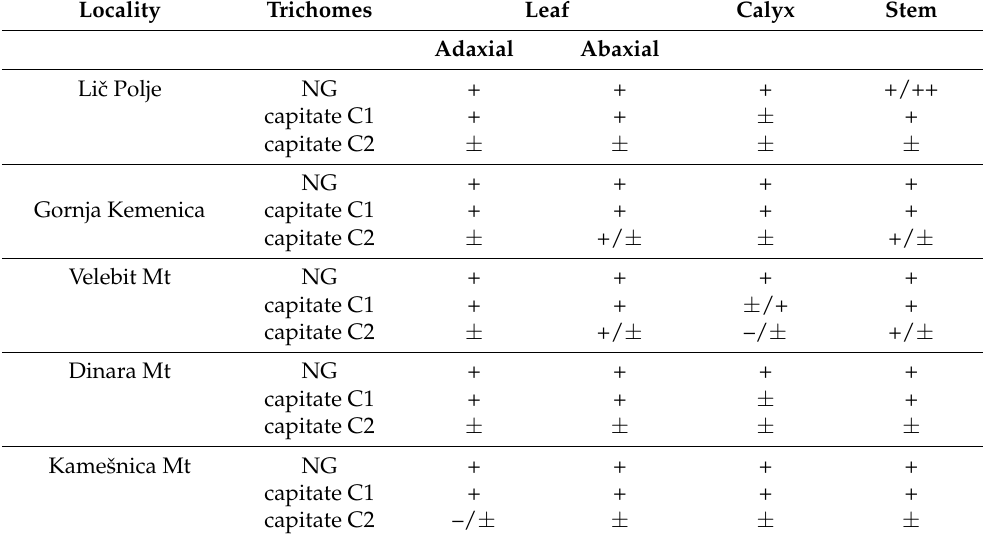
Table 3. Occurrence and frequency of trichomes in Barrelier’s Speedwell. NG = non-glandular trichomes, C1 = subtype 1 of capitate trichomes, C2 = subtype 2 of capitate trichomes. Trichomes